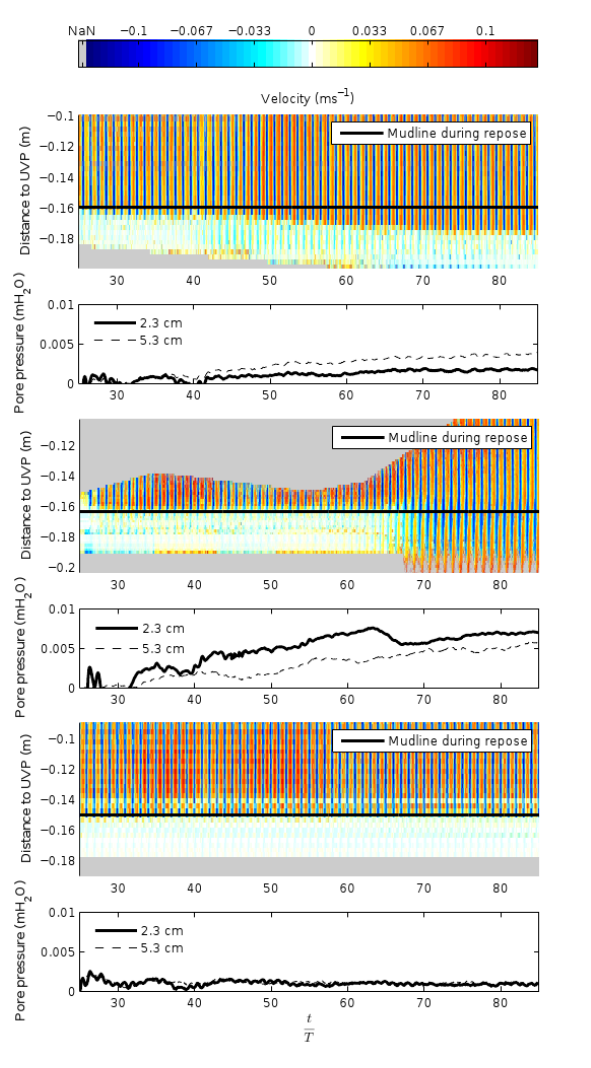
Fig. 3. From top to bottom: Experiment #1 ( ρ b = 1548kgm − 3 ), progressive motion of the bed starting from the upper lay- ers, corresponding to the τ Y < τ 0 condition. Experiment #4 ( ρ b = 1608kgm − 3 ), liquefaction of the bed due to pore pressure build-up, corresponding to the τ d > τ Y > τ 0 condition. Experiment #3 ( ρ b = 1738 kgm − 3 ), no mobilization of the bed, corresponding to the τ Y > τ d condition. The colored charts show the velocity pro- file series measured with the UVP at each experiment during sixty waves, the black line indicates the location of the top of the bed at the beginning of the experiment, cold colours indicate velocities towards the sensor and warm colours away from the sensor, grey zones indicate low quality data due to low acoustic backscatter in- tensity. The black an white charts shows the period-averaged pore- water pressure for two different heights (2.3cm and 5.3cm below the initial mud-water